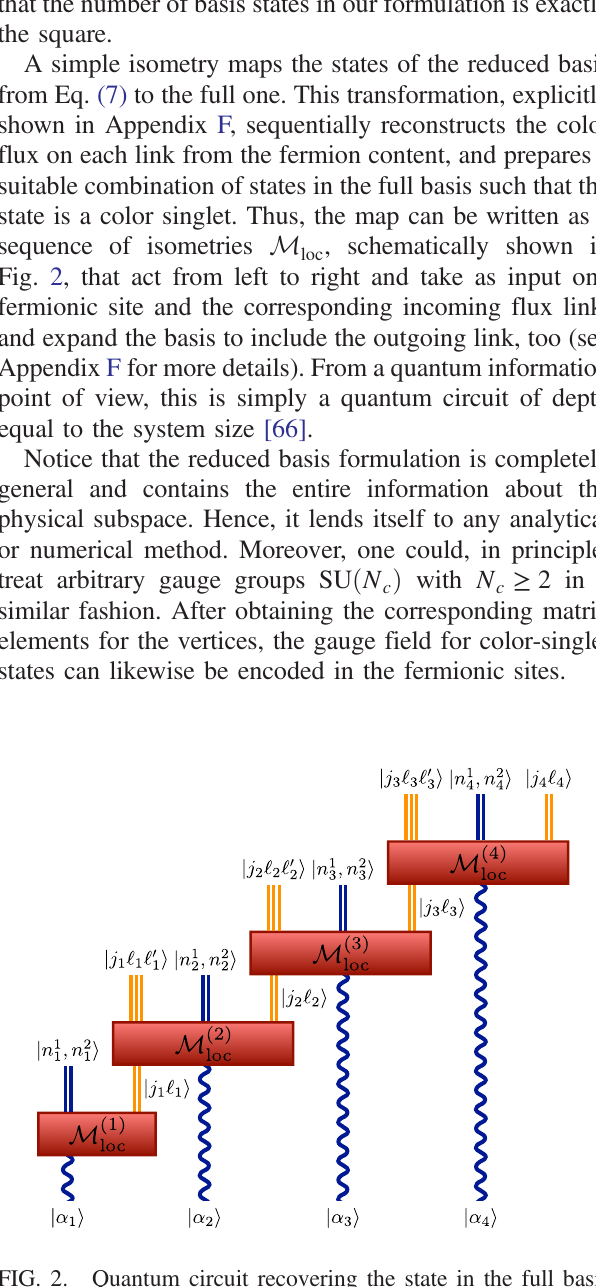
FIG. 2. Quantum circuit recovering the state in the full basis from our formulation for a system of four